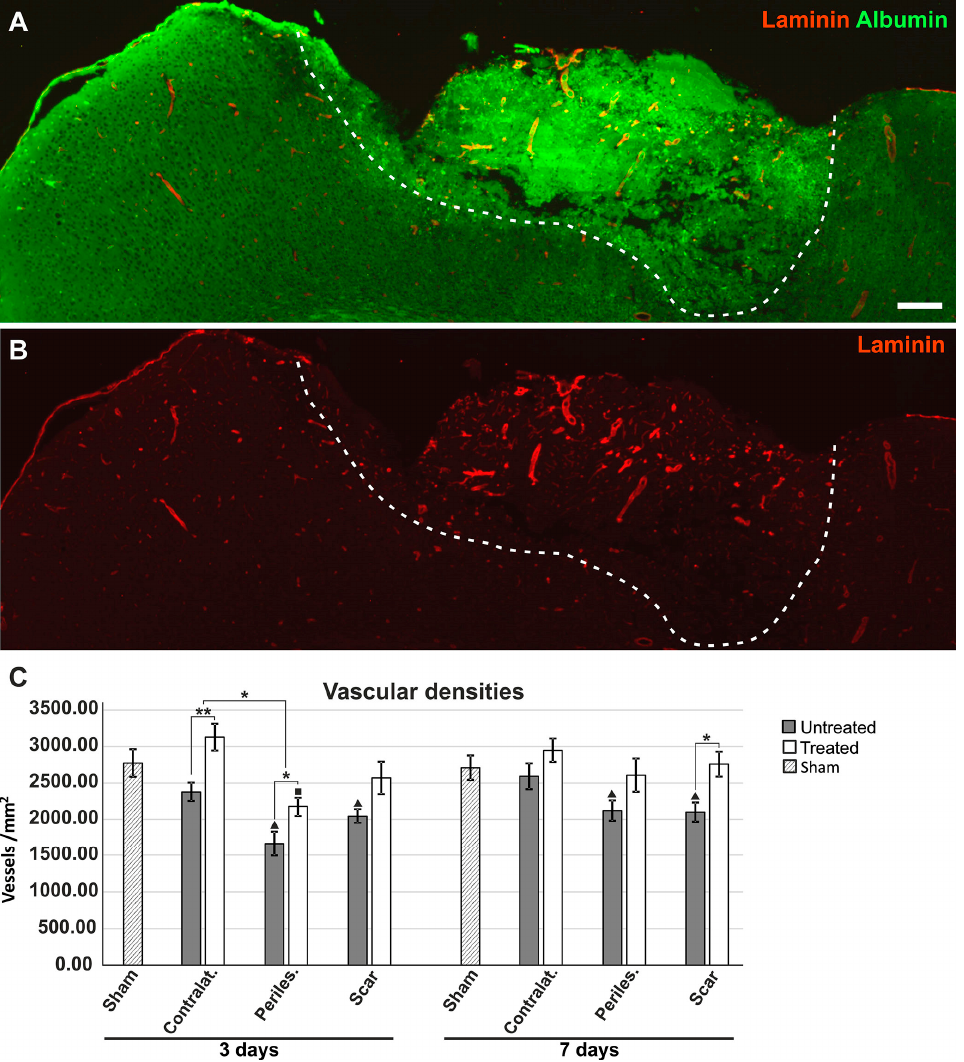
Figure 4. Increased vascular densities in TGN-020-treated animals. ( A , B ) Immunohistochemistry for albumin and laminin-1 reveal increased/conserved laminin expression in the infarcted areas (delineated by a dotted line) and adjacent tissue, in a 3-day post-MCAO TGN-020-treated animal; ( C ) Vascular densities show increased values for 3-day treated animals for the contralateral hemisphere and perilesional ipsilateral hemisphere, while in 7-day surviving animals, the difference was significant only for the scar tissue (* p < 0.05, ** p < 0.01; ■ p < 0.05 and ▲ p < 0.01 (for pathological regions versus sham animals), using a one-way ANOVA followed by a post hoc Fisher’s LSD test, n = 5–6/group). The differences between 3 and 7 days are not included for reasons of clarity. Data are expressed as the means ± SEM. Scale bars in the micrographs represent 200 µm.